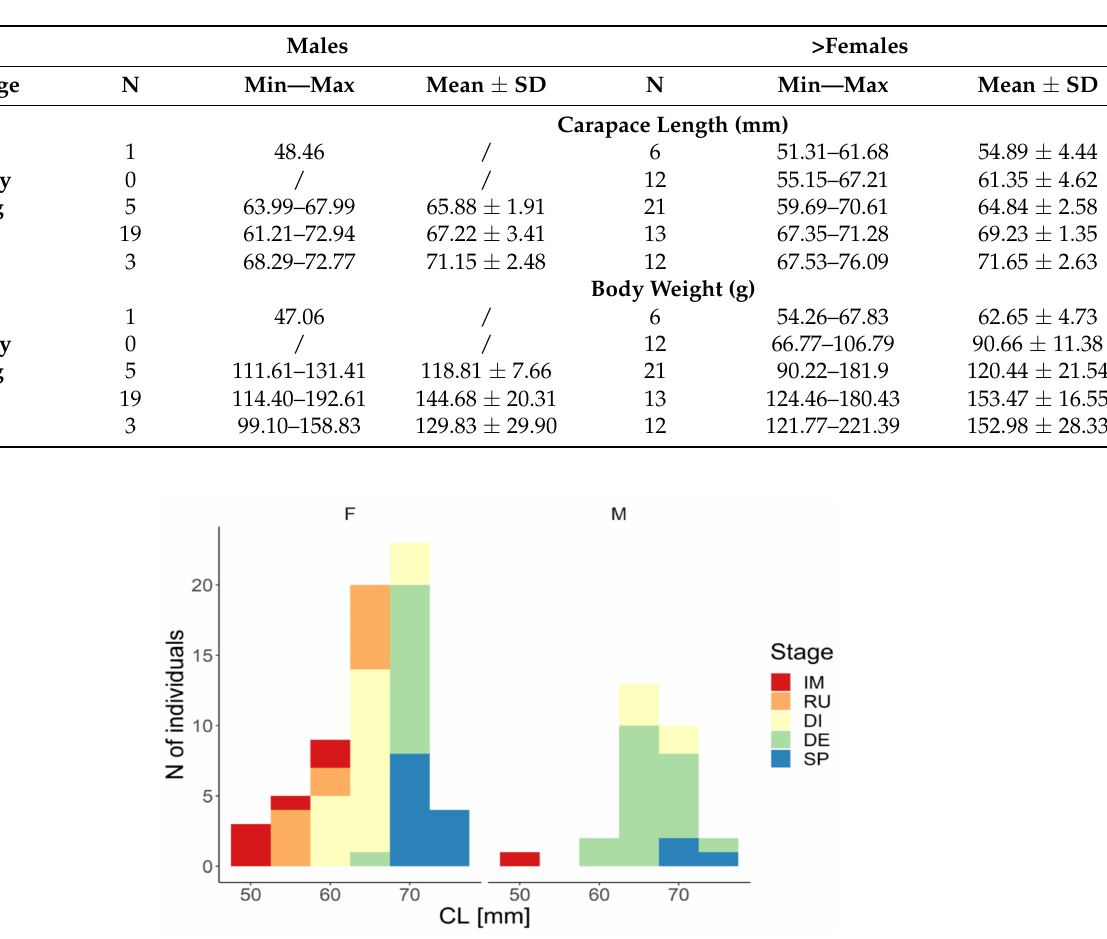
Table 4. Number of individuals (N), range (min—max) and mean values with standard deviation (SD) of carapace length and body weight for each maturity stage of Calappa granulata collected from the central eastern Adriatic Sea.